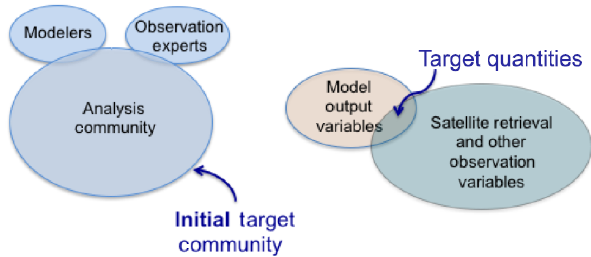
Figure 1. Two schematics that illustrate key motivations and guid- ing considerations for obs4MIPs. Left: depiction of the large and growing community of scientists undertaking the climate model analysis who are not necessarily experts in modeling or in the de- tails of the observations. Right: depiction of the large number of quantities available from model output (e.g., CMIP) and obtained from satellite retrievals, highlighting that a much smaller subset fall in the intersection but are of greatest relevance to model